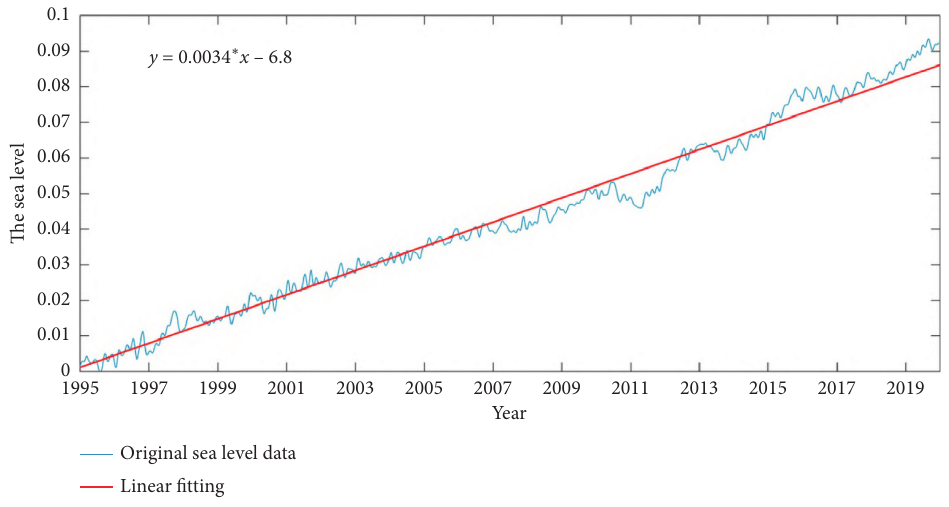
Figure 1: The original sea level data and its linear fitting. Table 1: Refugee population data in 241 countries and regions from 2008 to 2018.